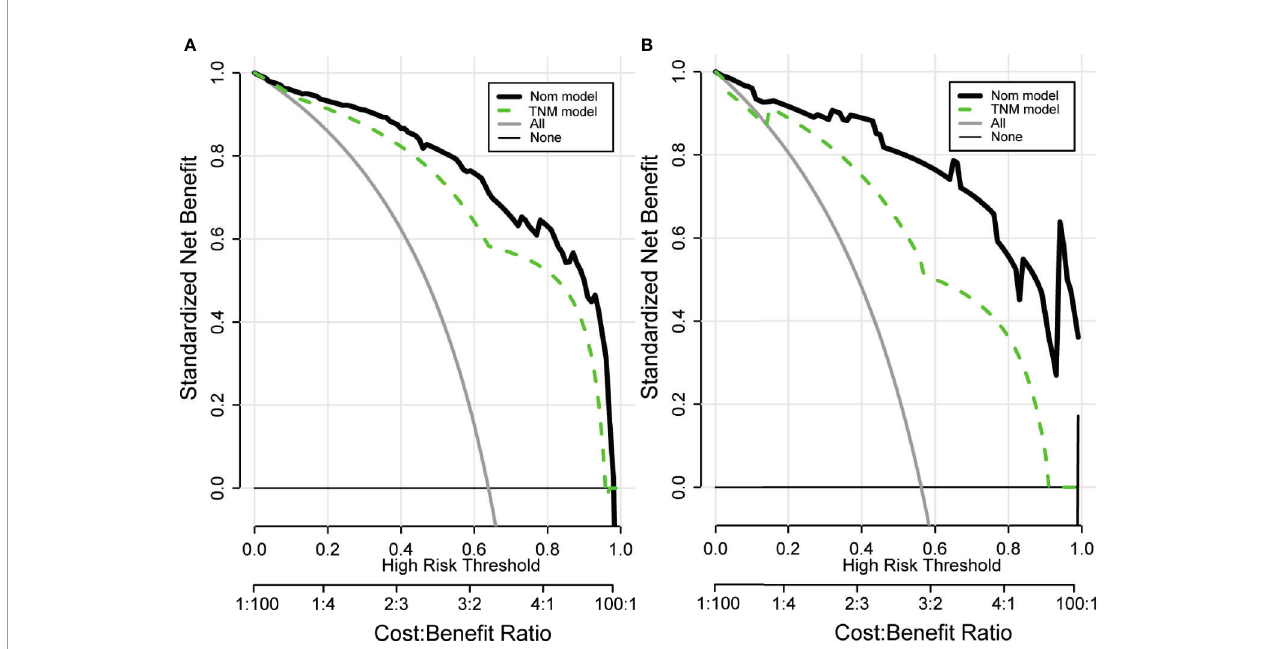
FIGURE 7 | Clinical decision curve analysis (DCA) of the training group (A) and validation group (B) for clinical bene fi ts. Comparison of DCA between Nom model and TNM model. X-axis stands for threshold probability. Y-axis stands for the net bene fi t after the advantage minus the disadvantage. The black horizontal line indicates that all samples are negative, which means none of the patients received interventions and the net bene fi t is 0; The gray oblique line indicates that all samples are positive and all patients received interventions. Nom model included AFP, VHS, CV, RT, TNM, PTS. TNM Model included T-stage, N-stage, and